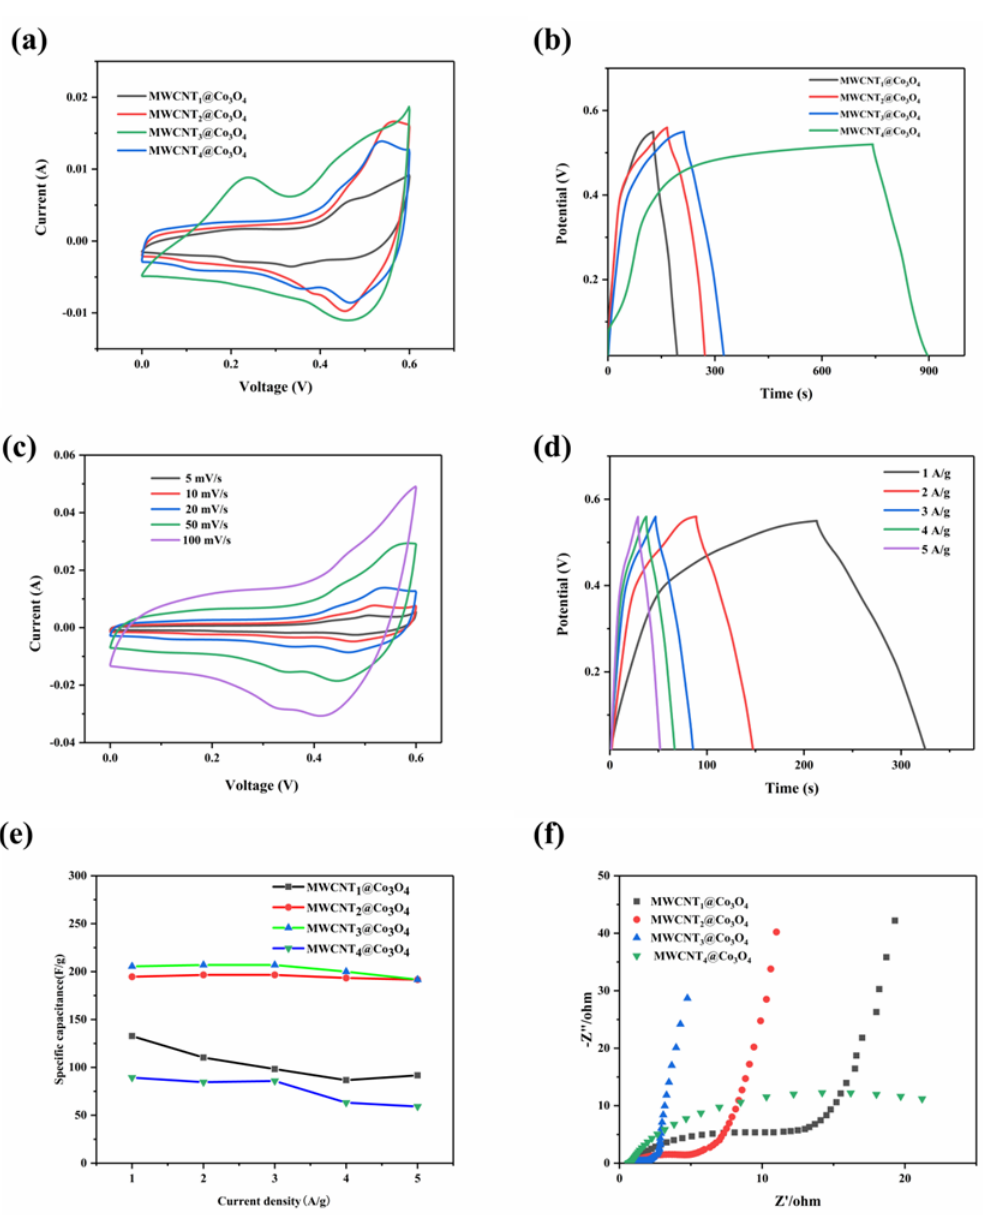
Figure 7. ( a ) CV curve of different mass ratios of MWCNT 3 @Co 3 O 4 composites at 20 mV s −1 sweep velocity; ( b ) GCD curve of the different mass ratios of MWCNT 3 @Co 3 O 4 composites at 1A g −1 ; ( c ) CV diagram of MWCNT 3 @Co 3 O 4 composite at 20 mV s −1 scanning speed; ( d ) GCD diagram of MWCNT 3 @Co 3 O 4 composites at different current densities; ( e ) magnification performance diagram of the different mass ratios of MWCNT 3 @Co 3 O 4 composites; ( f ) Nyquist diagram of the different mass ratios of MWCNT 3 @Co 3 O 4 composites with an illustration of its local enlarged view.